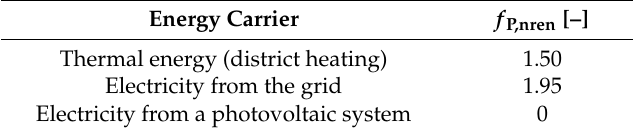
Table 1. Non-renewable primary energy conversion factors ( f P,nren )